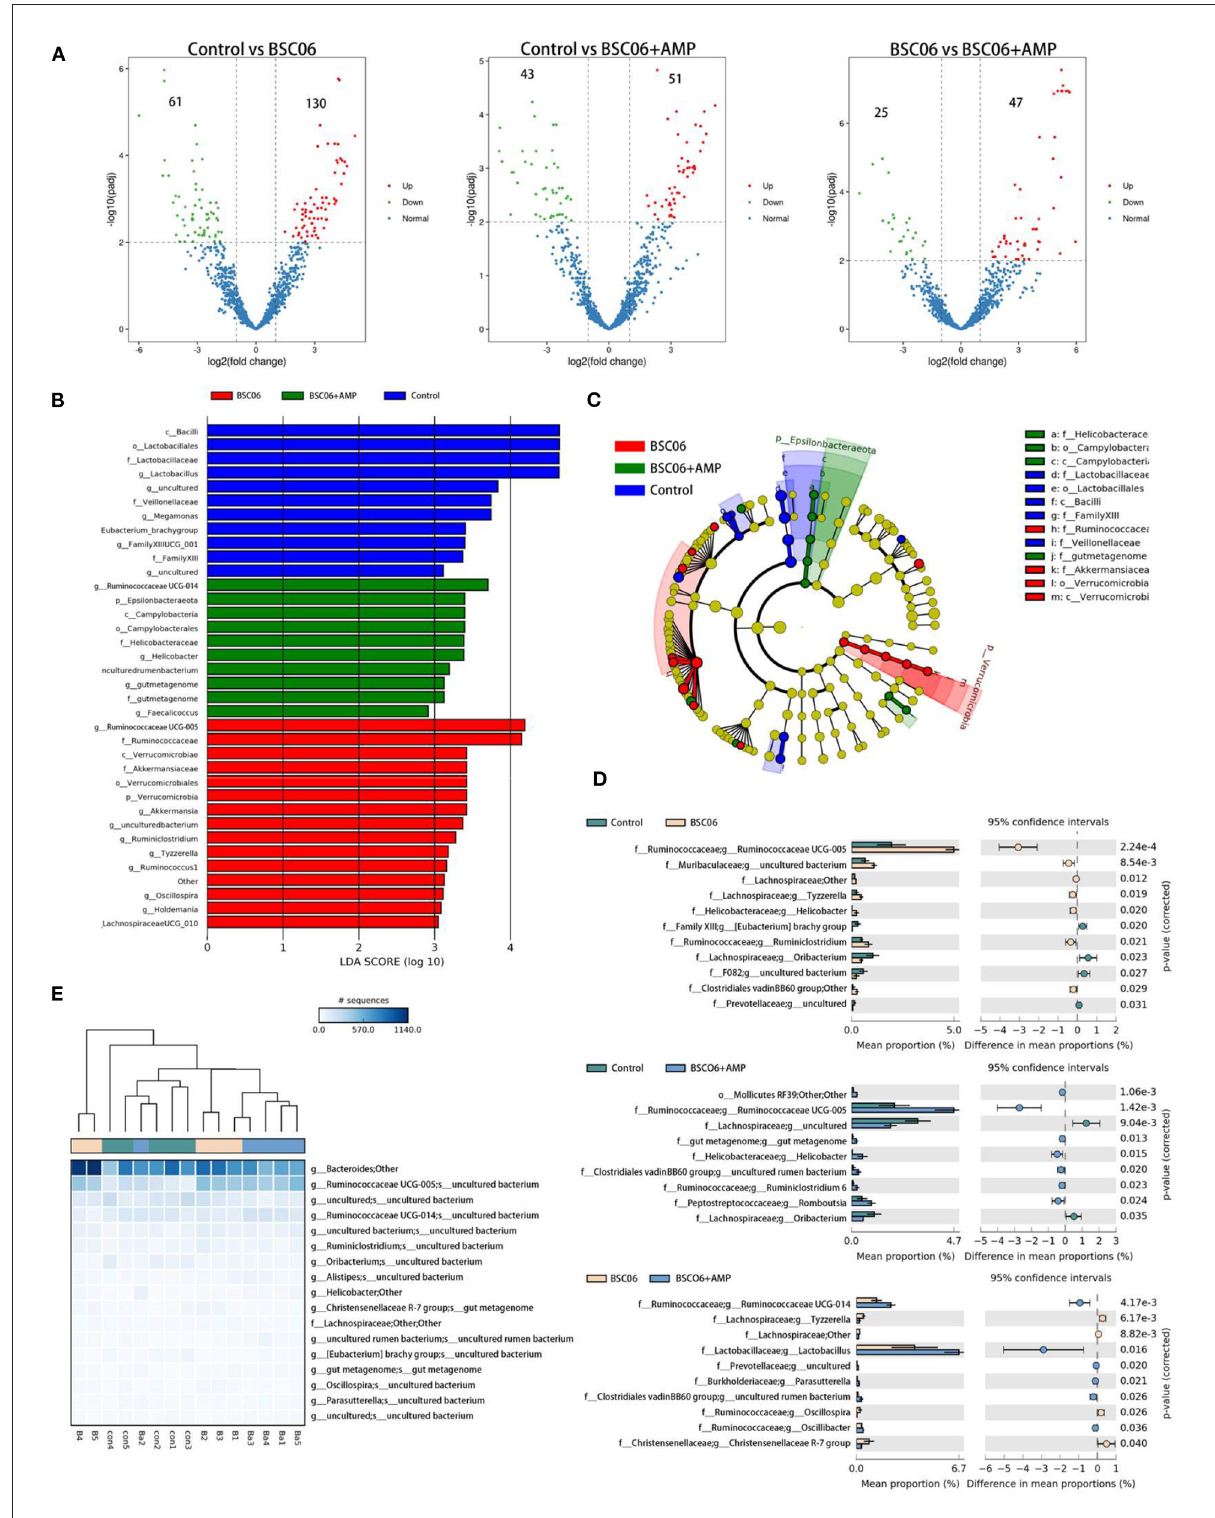
FIGURE6 (A) Analysis of changes in absolute species abundance between groups using Deseq. (B,C) LEfSe bar and LEfSe cladogram. (D) Genus differences between two or three groups (E) were analyzed by